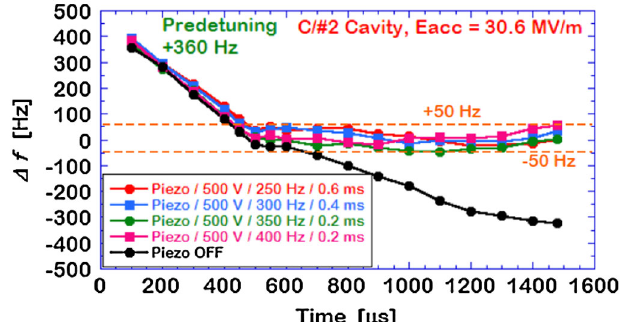
FIG. 24. (Color) Successful compensation of Lorentz force de- tuning by detuning and piezo tuner. Several optimized parame- ters for the frequency and delay time were found at the fixed applied voltage of þ 500 V for the piezo drive pulse. The data in the case of no piezo drive (black dots) are added for comparison. (Detailed results are also found in